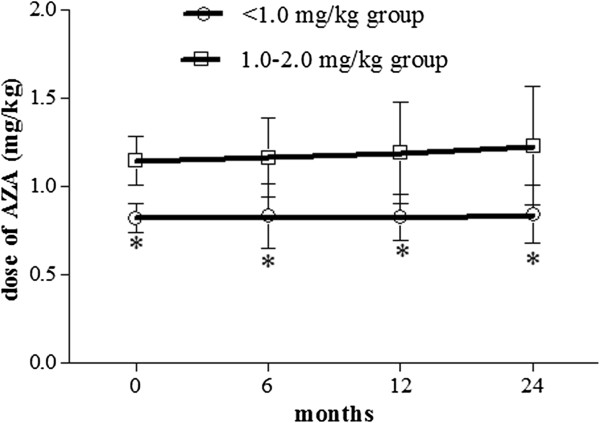
Dose of azathioprine in <1.0 mg/kg group and 1.0-2.0 mg/kg group at different time points. The patients treated with AZA were divided into <1.0 mg/kg group and 1.0-2.0 mg/kg group according to their initial dose. The doses of AZA were adjusted according to efficacy and tolerance during the 2-year period. The mean dose of <1.0 mg/kg group remained under 1.0 mg/kg. * P < 0.01 compared the dose of <1.0 mg/kg group with 1.0-2.0 mg/kg group.